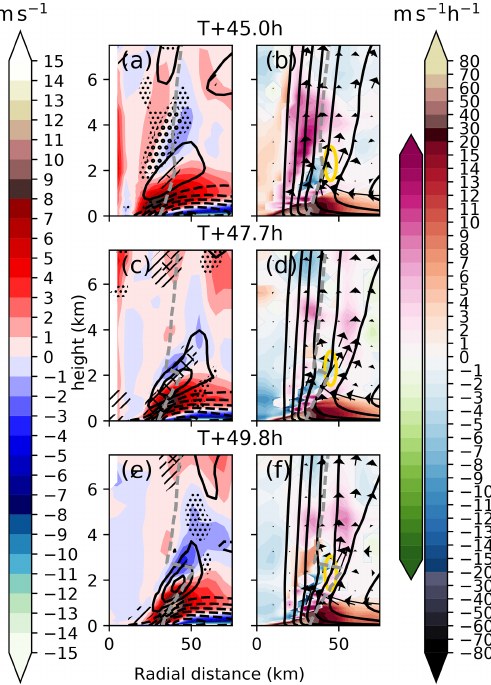
Figure 15. Panels (a, c, e) show, as a function of height and ra- dius, the agradient wind (shading, ms − 1 , left colour bar), the ra- dial wind in intervals of 4ms − 1 with dashed lines indicating neg- ative values, the tendency in tangential wind as small dots show- ing + 2ms − 1 h − 1 , large dots showing + 4 ms − 1 h − 1 , line hatches showing − 2ms − 1 h − 1 , and cross hatches showing − 4ms − 1 h − 1 . Panels (b, d, f) show angular momentum (lines in units of 5 × 10 − 5 m 2 s − 1 ) and the secondary circulation as arrows in the plane of the cross section (with the boundary layer strong inflow omitted for clarity). The shading shows the contribution of the sum of the radial and vertical advection of angular momentum to the tangential wind budget. The colour scale used indicates which is the dominant term. If radial advection dominates over vertical advection then the blue/red shading is used and if vertical advection is dominant over radial advection then the green/purple scheme is used. For exam- ple green shading implies that the radial and vertical advection of angular momentum causes a negative tangential wind tendency and that the vertical term dominates. Also shown is RMW as the dashed grey line. The times shown are (a, b) T + 45h, (c, d) T + 47 . 4h, and (e, f) T + 49 . 8h (the first three panels in Fig. 9). A region of interest is denoted by the yellow